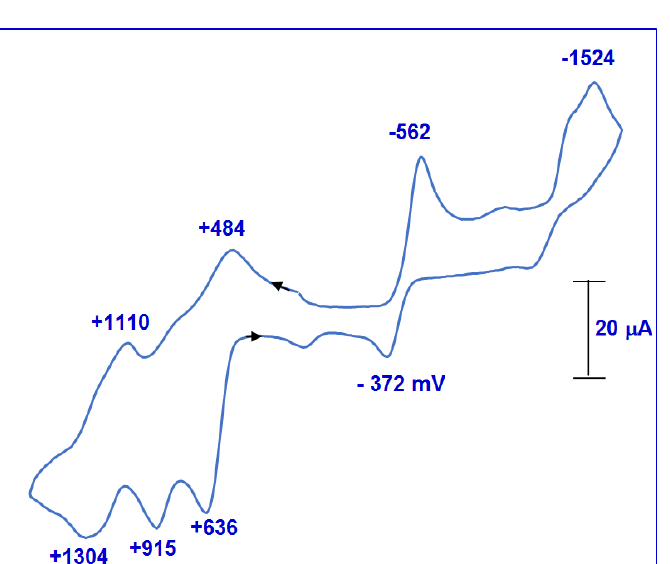
Figure 1. Cyclic voltammogram of [RuNOTSP]Br in MeOH (10 − 3 M, 10 − 1 M NBu 4 PF 6 , v = 50 mV/s). Three oxidation processes were observed in the anodic region at E ½ = ca. +560, +915, and +1207 mV, which could be tentatively assigned to the three stepwise one-electron oxidations designated in Equation